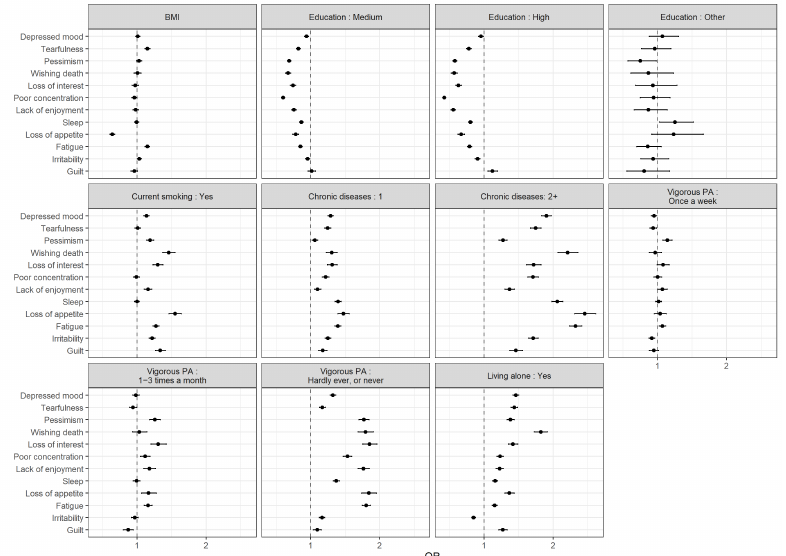
Figure 3. Factors associated with depressive symptoms (OR and 95% CI). Estimates were obtained from 12 separate logistic regression models (one for each symptom) including two-way interactions between age, sex and region and additional risk factors (education, BMI, current smoking, presence of chronic disease, vigorous physical activity, living arrangement ); age was modelled using restricted cubic splines (rcs). See Table 3 for sample sizes within each region and sex and for descriptive statistics.